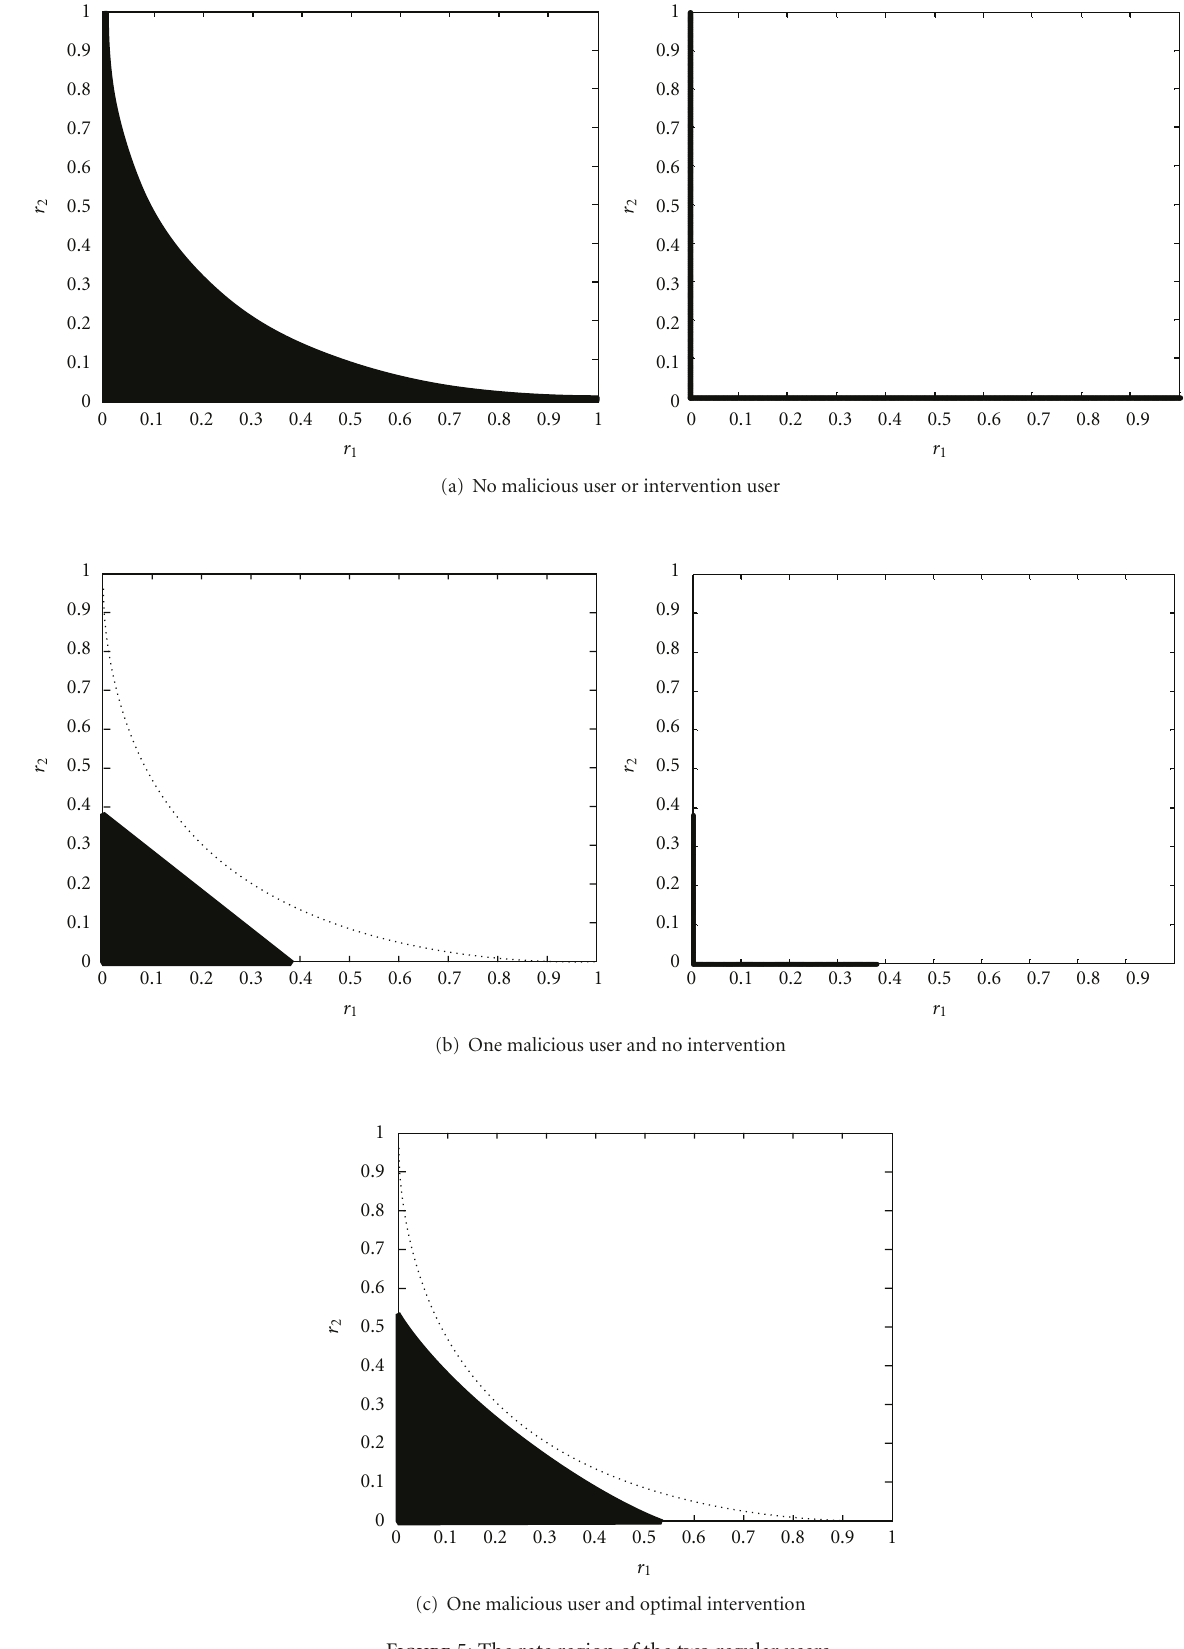
Figure 5: The rate region of the two regular